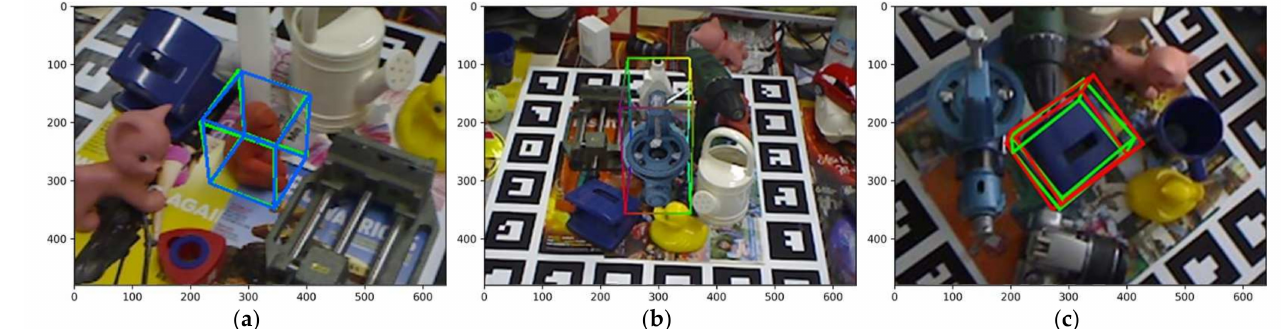
Figure 4. Results of convolutional neural networks applied on the LineMOD dataset 6D for ac- curate object pose estimation. We show an input RGB image, estimated pose, and ground-truth pose: ( a ) EfficientPose pose estimation; ( b ) SSD-6D pose estimation; ( c ) single-shot deep CNN pose estimation. The 2D matrix markers used in (a), (b) and (c) are only for the learning phase. They are interim results which is utilized to configure datasets.